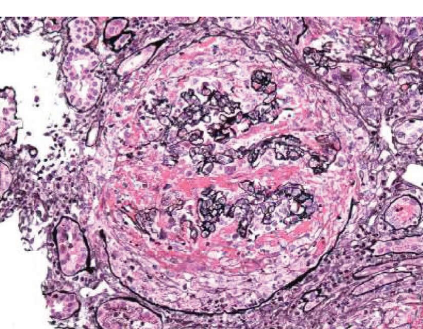
Figure 2: Light microscopy of glomeruli demonstrating the crescentic pattern of